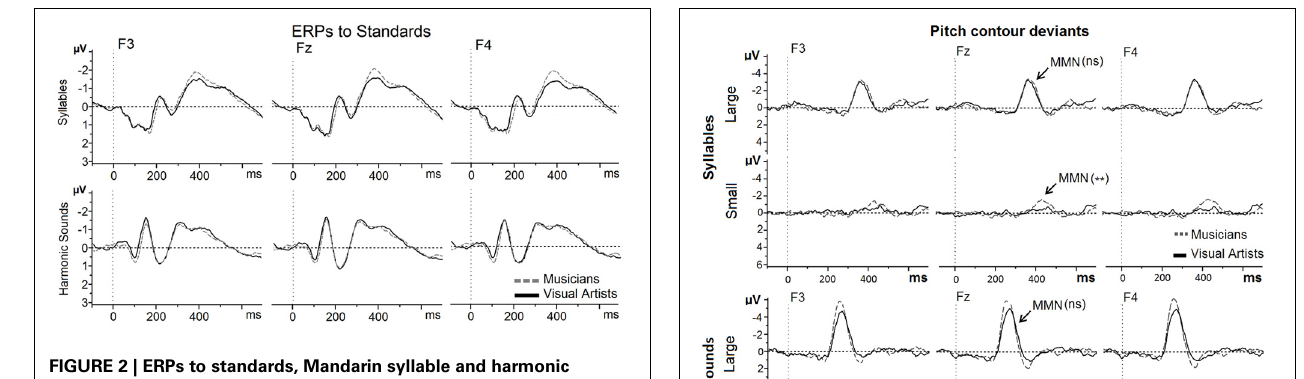
Mandarin syllables and in harmonic sounds recorded at Frontal sites (F3, Fz, and F4) are overlapped for musicians (gray dashed line) and visual artists (black solid line). On this and subsequent figures: ns means “not significant”; one ( ∗ ) and two stars ( ∗∗ ) represent significance with p < 0 . 05 and p < 0 . 01, respectively.